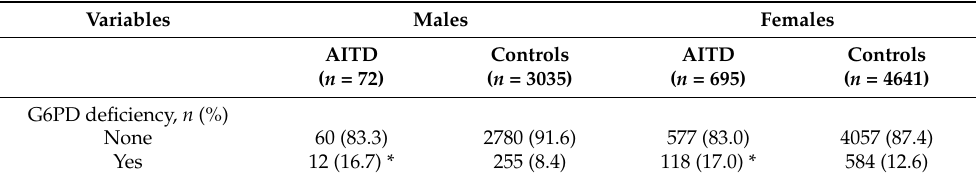
Table 2. Frequency of G6PD deficiency among study participants with autoimmune thyroid diseases (AITD) and controls stratified by sex.